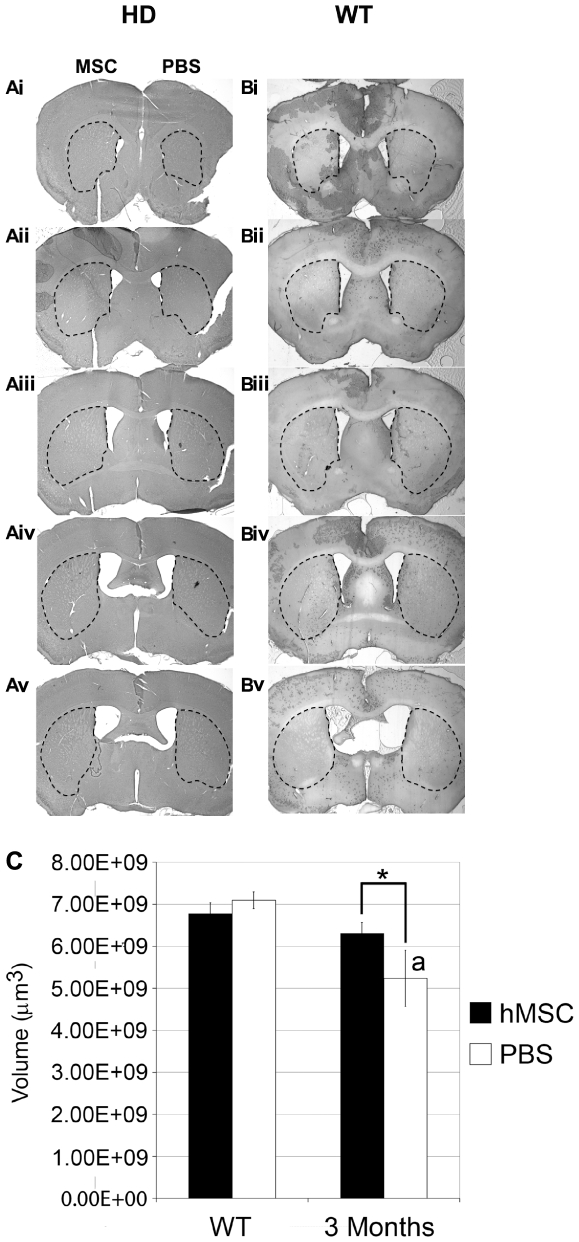
hMSC implantation decreased striatal atrophy in HD mice.Serial sections throughout the striatum were used for striatal volume analysis. Serial sections of the striatum are outlined in both HD mice receiving MSCs or PBS (Ai–Av) and control WT mice (Bi–Bv). There was an apparent increase in striatal volume after MSC implantation at 8 weeks compared to the contralateral, PBS injected hemisphere (Ai–Av). There was no apparent difference in the size of the striatum in the opposite hemispheres in WT mice (Bi–Bv). Scale bar = 1 mm. (C) Stereological analysis at 1 month post-implantation revealed a significant increase in striatal volume after hMSC implantation compared to PBS injection (n = 5−6; *). The PBS-injected striatum was significantly smaller than both the MSC-implanted (a) and PBS WT control striatum (b). There was no difference between the two hemispheres in the WT control group. *, a, and b denote p<0.05 by ANOVA with Holms-Sidak post-hoc analysis.